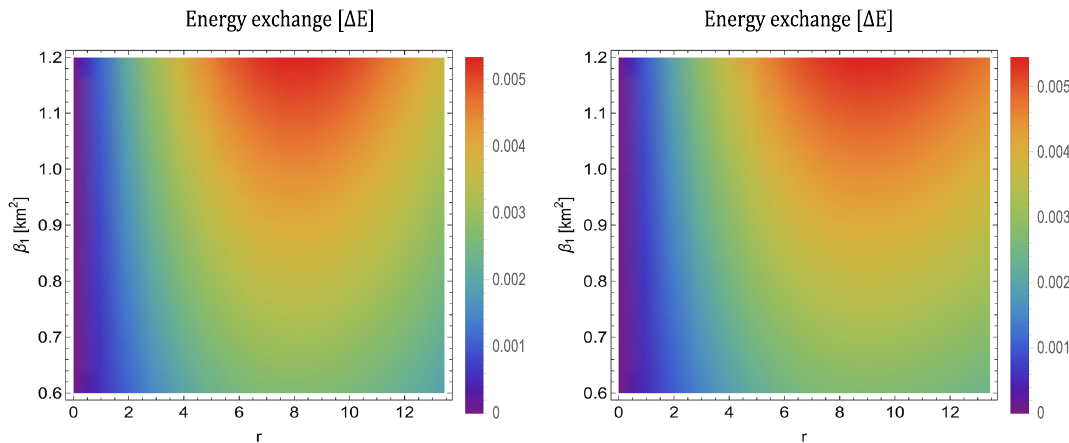
Fig. 9 Left panel: The variation of energy exchange (cid:18) E on r − α plane for C = 0 . 0043 km − 2 , β 1 = 0 . 66 km 2 and A / B = − 0 . 5. Right panel: The variation of energy exchange (cid:18) E on r − α plane for C = 0 . 0043 km − 2 , β 1 = 0 . 66 km 2 and A / B = 0 . 5